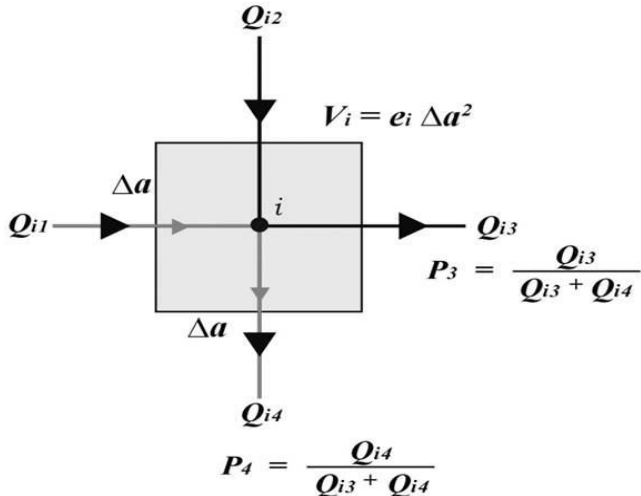
Figure 1. Solute particles’ selection of routes at intersection i : black lines indicate the flow direction, and gray lines the particle routes. Random numbers exist between 0 and 1.